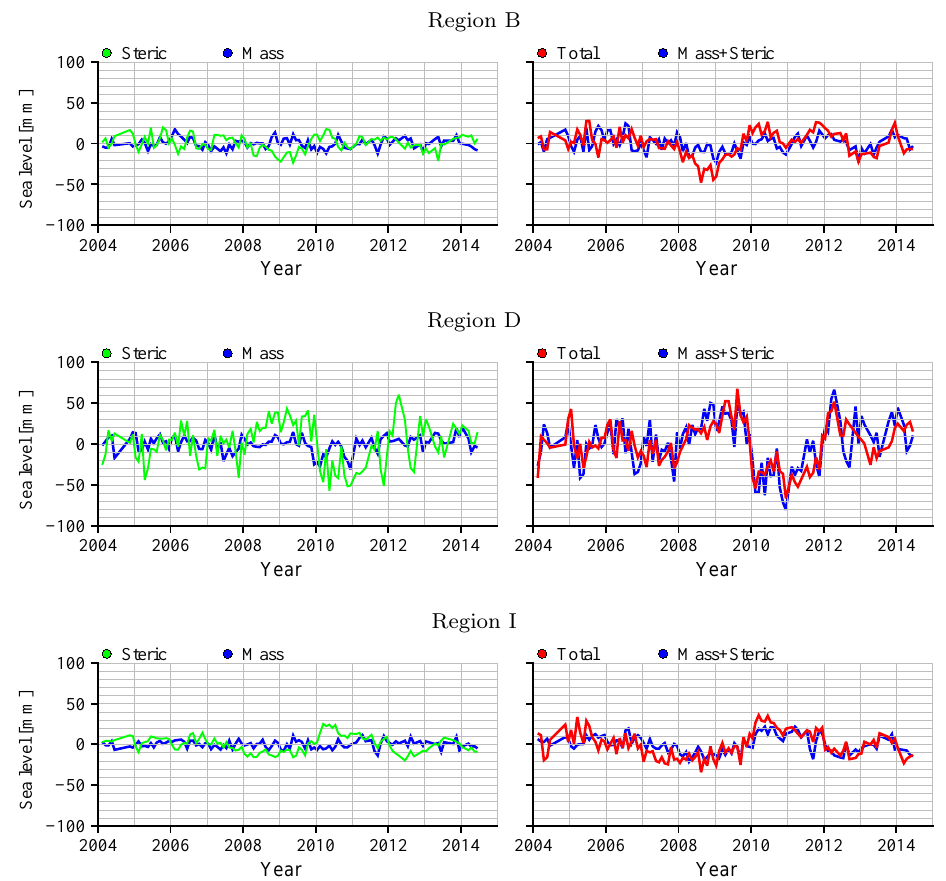
Figure 10. Time series of sea level components for polygons B, D and I after removing the trends and the annual and semiannual signals. Left: ITSG90-W mass in blue and steric sea level in green. Right: total sea level from altimetry in red and the sum of steric sea level and mass in